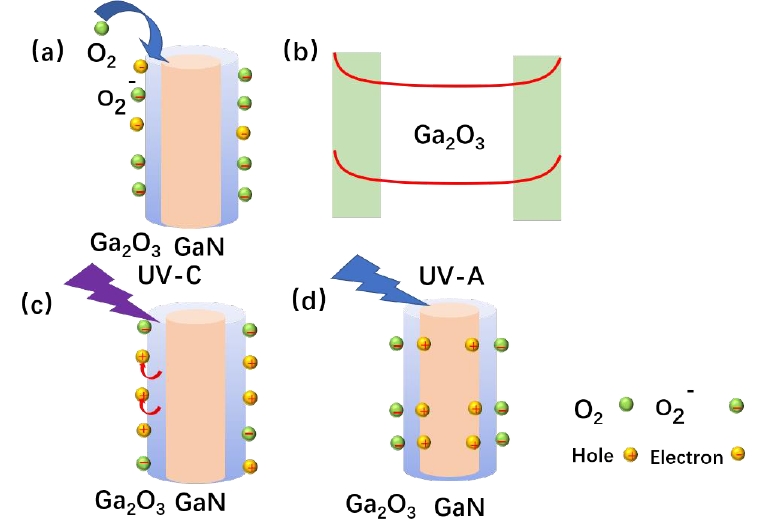
Figure 4. I − V characteristics of samples A ( a ) and B ( b ) in the dark and under 254 nm/365 nm UV illuminations.